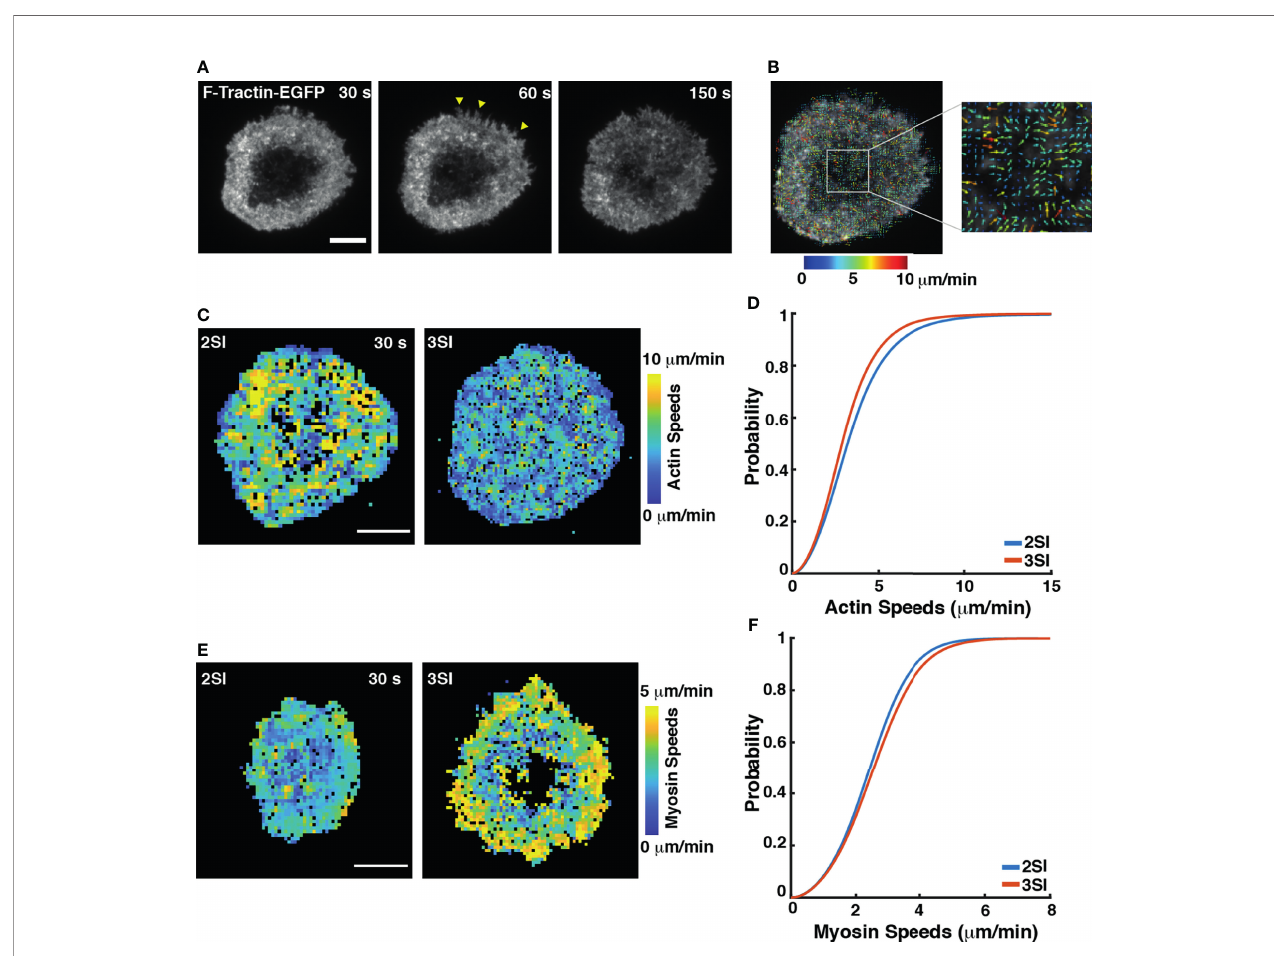
FIGURE 3 | 3SI stimulation alters actomyosin fl ow speeds in CTLs: (A) Representative time-lapse images of a 3SI CTL expressing F-tractin-EGFP spreading on an anti-CD3-coated coverslip and imaged using TIRF microscopy. Yellow arrows show actin protrusions. (B) Output from STICS analysis showing actin fl ow vectors at the immune synapse. The color of actin fl ow vectors corresponds to the magnitude of actin speeds, as represented by the color bar. (C) Heat maps showing magnitudes of actin fl ow speeds over the synapse at the indicated timepoint for 2SI and 3SI CTLs. Colors correspond to speeds as indicated by the color bar. (D) Cumulative distribution function of actin fl ow speeds obtained from STICS analysis of 2SI and 3SI CTLs. n=15 cells for 2SI and 12 cells for 3SI from 6 independent experiments. For actin speeds, p= 8.09e-06, two sample Kolmogorov-Smirnov test. Scale bars = 5 µm. (E) Heat maps showing myosin fl ow speeds at the indicated time point in 2SI and 3SI cells. (F) Cumulative distribution function of myosin fl ow speeds obtained from STICS analysis of 2SI and 3SI CTLs. n=11 cells for 2SI and 17 cells for 3SI from 3 independent experiments. For myosin speeds, p=8e-04, two sample Kolmogorov-Smirnov test. Scale bars = 5